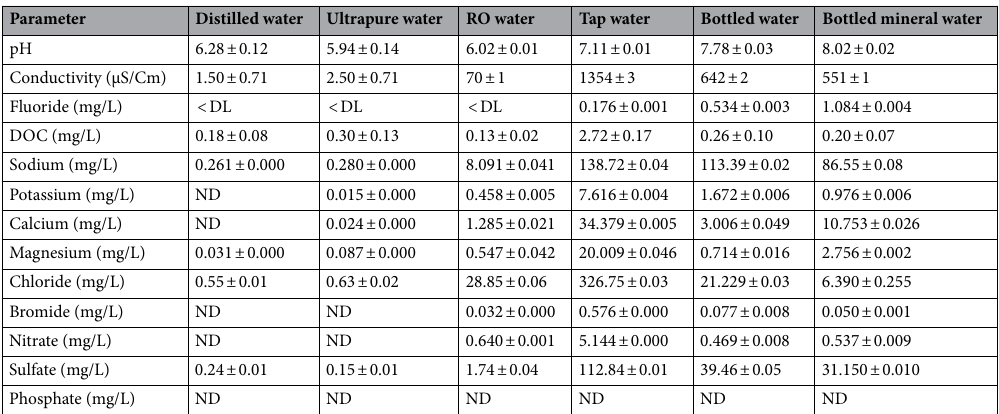
Table 3. Composition of the different ty of water used to prepare the tea infusion. The concentration of fluoride in distilled water, ultrapure water, and RO water was lower than the detection limit (DL) of 0.02 mg/L. ND, not detected.